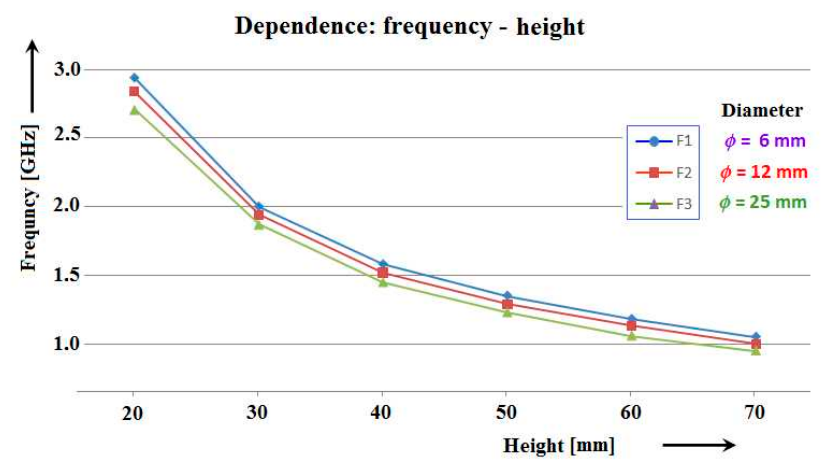
Figure 8. Dependence of resonant frequencies of cylindrical antennas on their length.